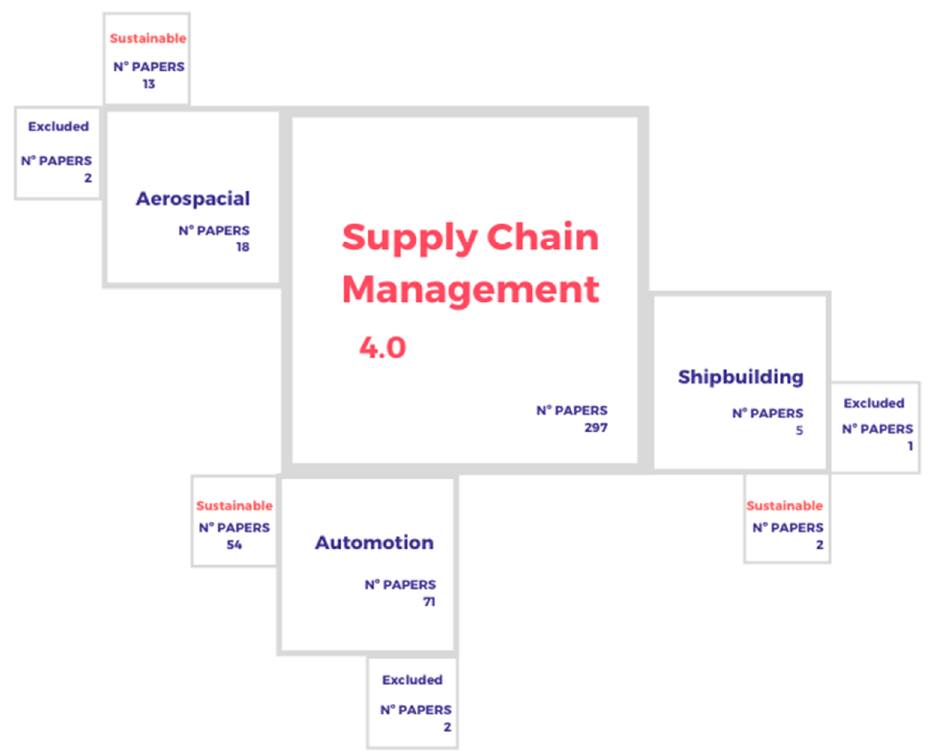
Figure 3. Articles considered from each sector.